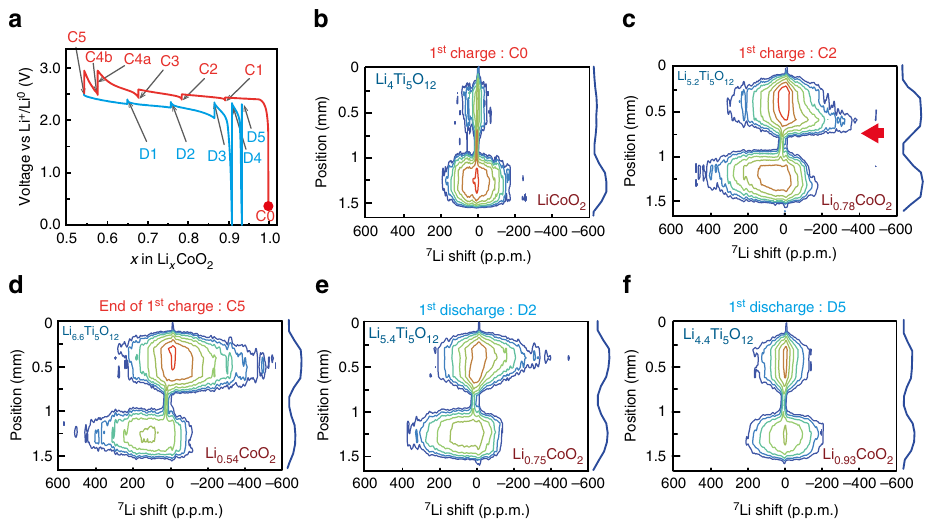
Figure 3 | In situ S-ISIS spectroscopic images of the LCO/LTO battery. ( a ) Electrochemical profile of the in situ battery cycled so that Li 0.5 CoO 2 is reached theoretically in 25h (C/25). The starting point (pristine) is marked as a red dot. The vertical lines are due to voltage relaxation before the acquisition of the images. ( b – d ) Images recorded upon charge, corresponding to pristine (C0), x ¼ 0.78 (C2) and x ¼ 0.54 (C5). ( e ) Battery at half-discharge ( x ¼ 0.75) and ( f ) after one cycle ( x ¼ 0.93). The colour code of the contours is the same in all plots.